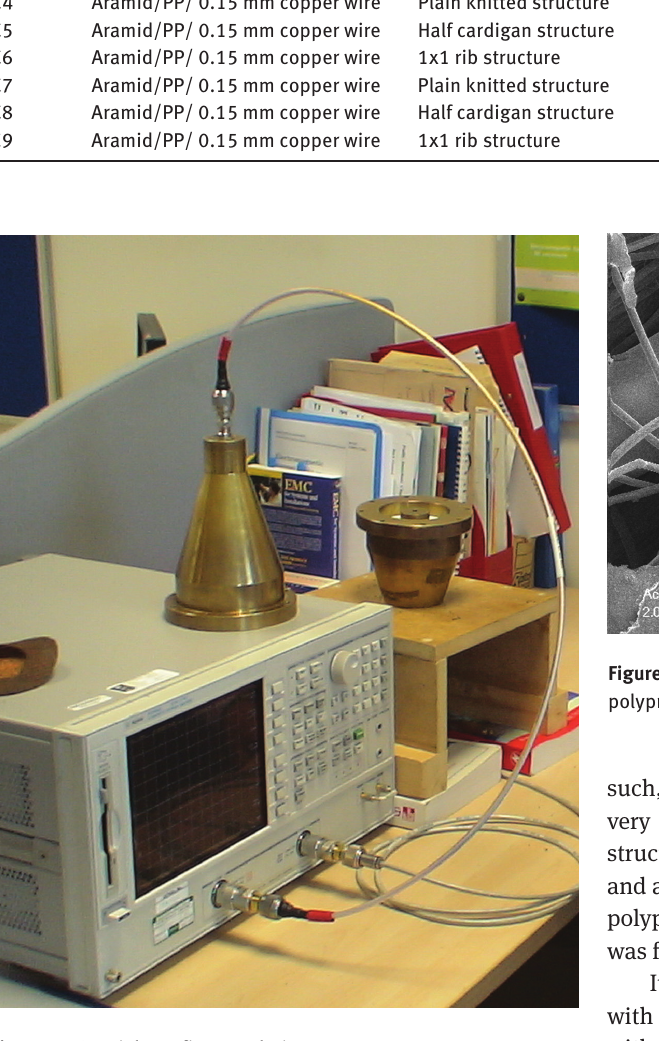
Figure 3 Coaxial test fixture relating to ASTM D 4935.